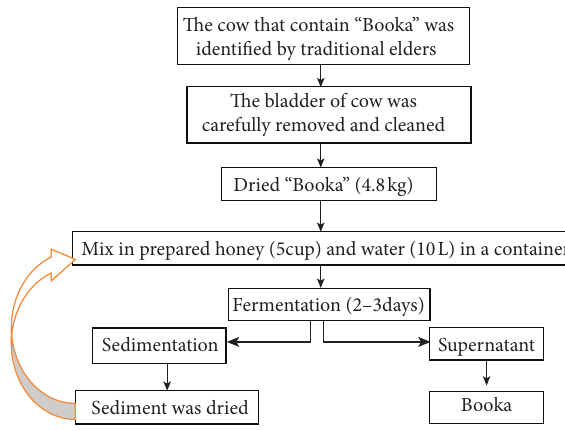
Figure 5: Flow chart of Booka production [23] by some